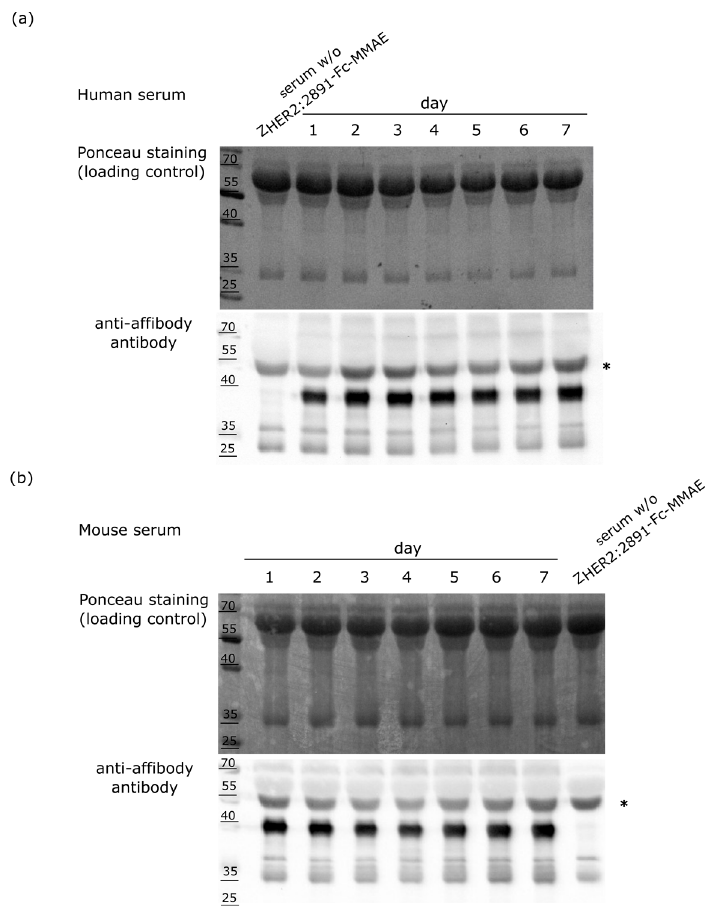
Figure 6. The stability of Z HER2:2891 -Fc-MMAE in ( a ) human and ( b ) mouse plasma analyzed by Western blotting. The asterisk indicates a nonspecific band.